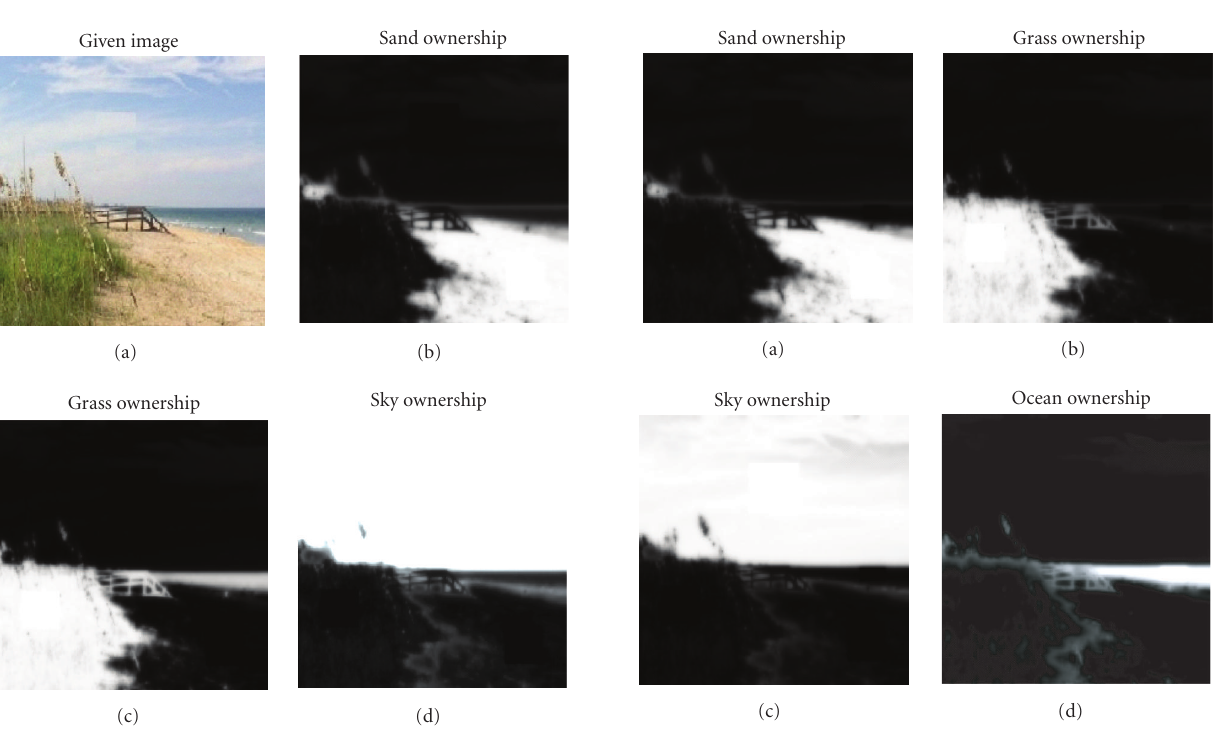
Figure 8: Soft Mumford-Shah segmentation with three phases corresponding to the supervision on Figure 2(a). Plotted here are the three ownership distributions p 1 ( x ), p 2 ( x ), and p 3 ( x ). Due to “under”-supervision, namely the number K of specified patterns is less than that of the visually meaningful ones, the grass pattern has “absorbed” the ocean pattern due to the greenish color they happen to share.